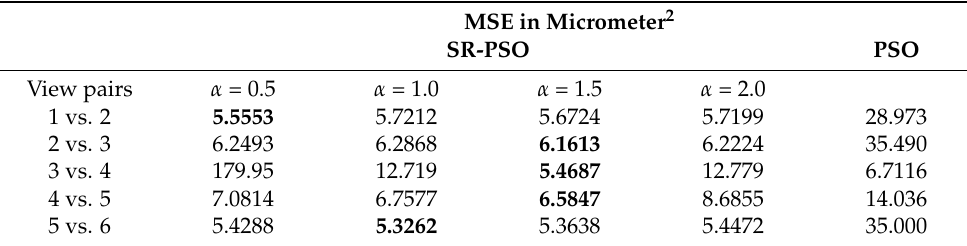
Table 9. MSE from SR-PSO with ICP and PSO with ICP for the orthodontic-tooth model (the best value is in